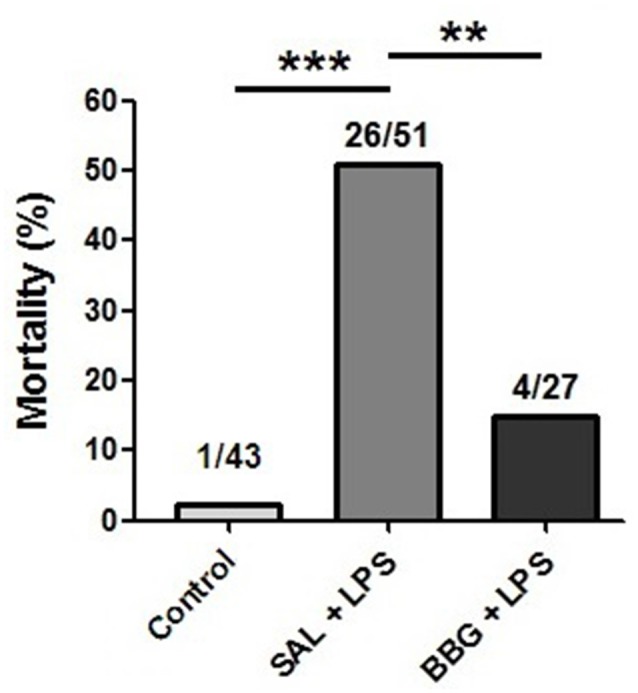
Effects of neonatal lipopolysaccharide (LPS) and brilliant blue G (BBG)-treatment on the mortality. BBG increased survival rate in LPS-treated rats. Data on bars represent percentage of dead animals (numbers listed above bars). **p < 0.01, ***p < 0.001.